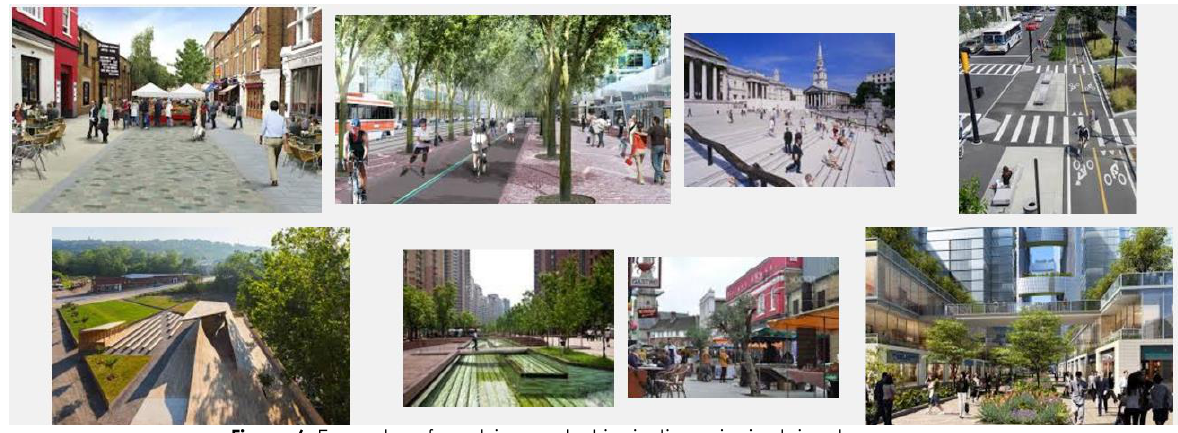
Figure 6. Examples of applying pedestrianisation principals in urban spaces.